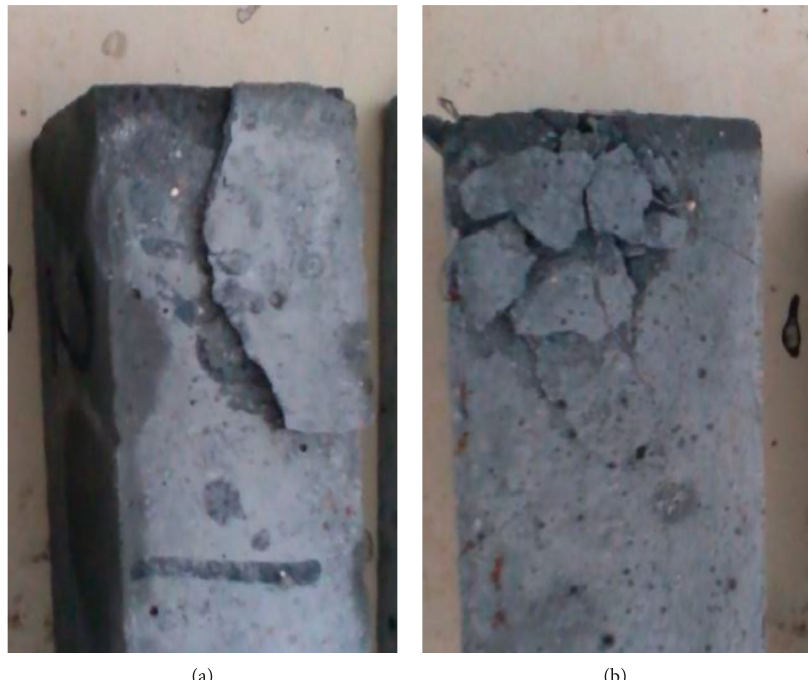
Figure 4: Cracked UHPC specimens (40mm × 40mm × 160mm) after enduring 250 freezing-thawing cycles: (a) plain UHPC and (b) UHPC-1%.